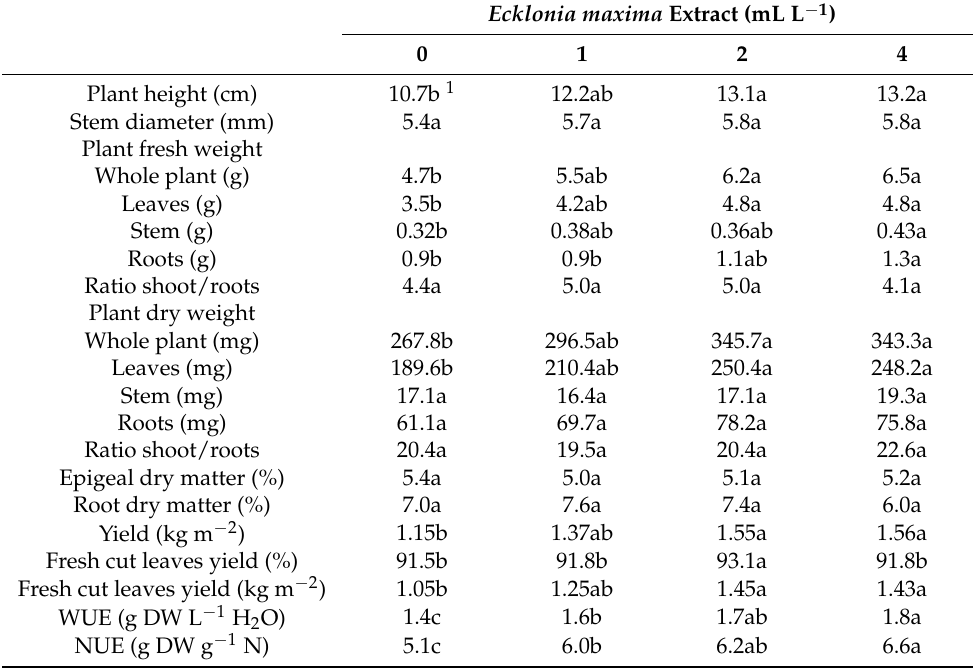
Table 1. Yield and morphological characteristics of green leaf lettuce plants grown in nutrient solutions added with different concentrations of Ecklonia maxima